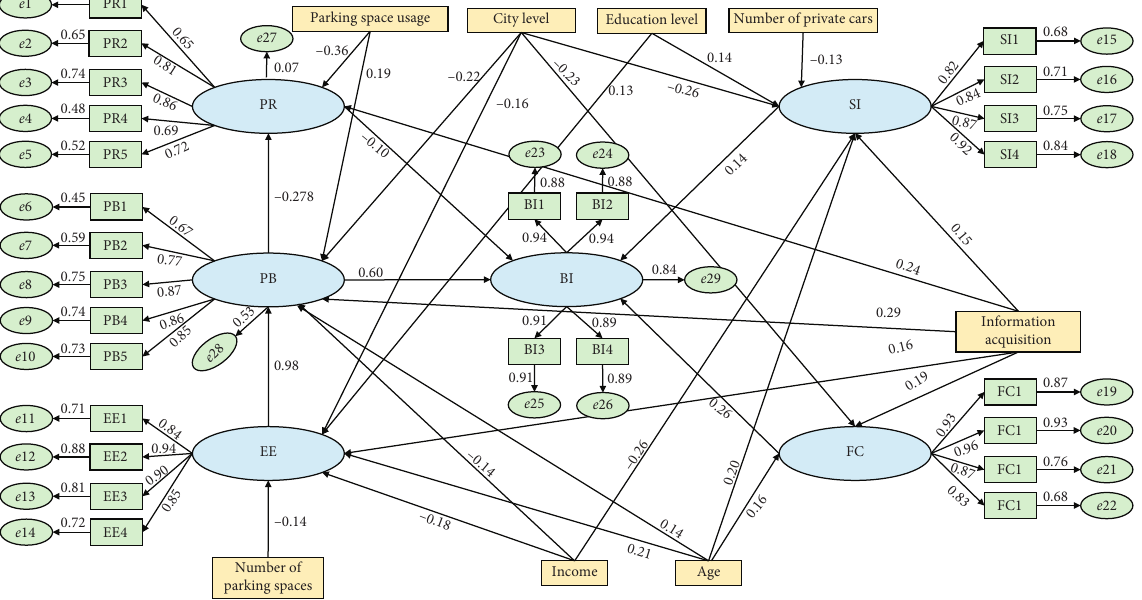
Figure 2: MIMIC model of the sharing intention of parking space.